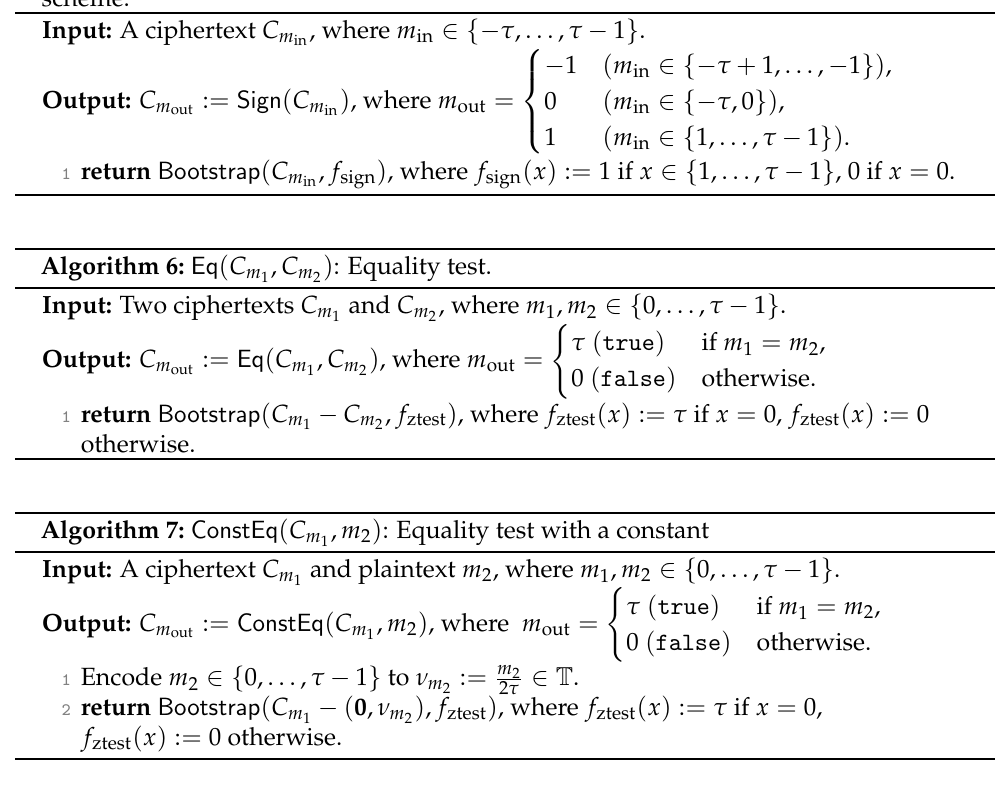
) : Homomorphic sign evaluation in our bootstrapping Algorithm 5: Sign ( C m in scheme.